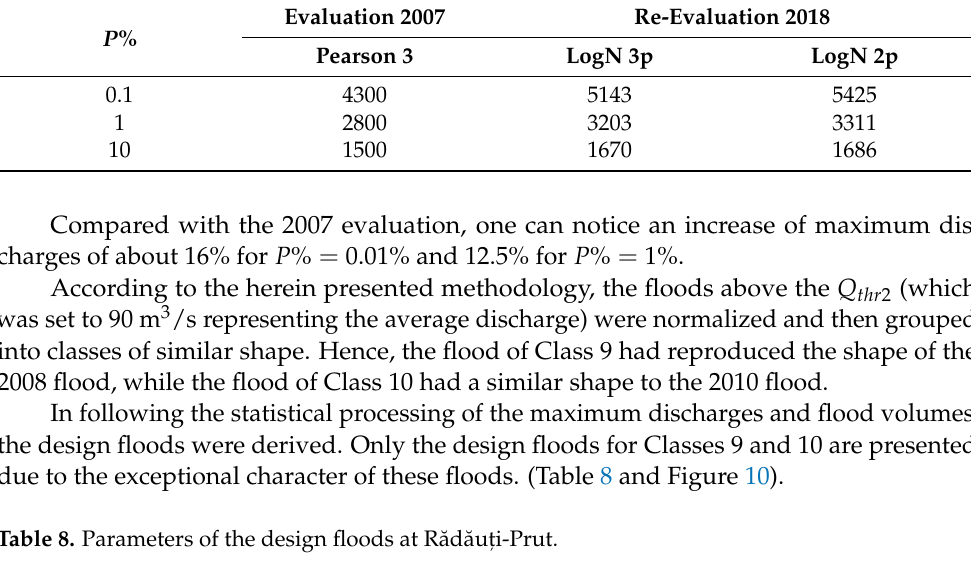
Table 7. Maximum discharges at Rădăuți -Prut.